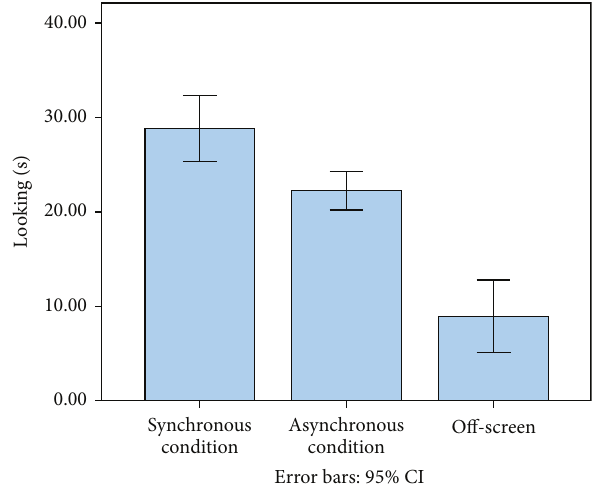
Figure 1: Preferential looking by stimulus